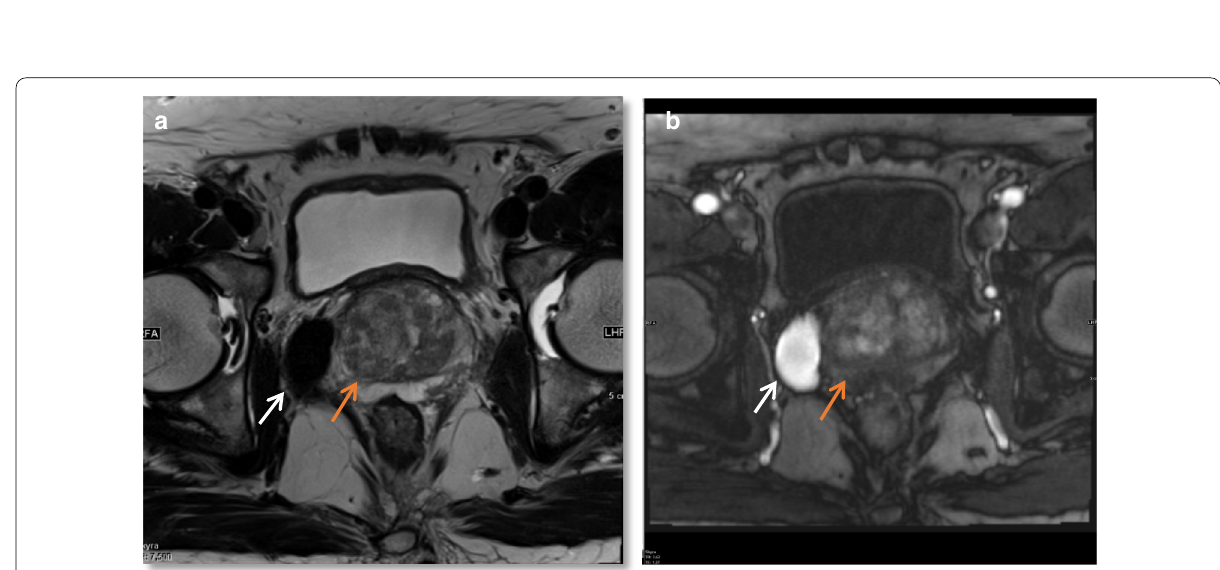
Fig. 25 Periprostatic venous varix a Axial T2W image shows a flow void (white arrow) to the right of the prostate gland (red arrow) and ( b ) dynamic post-contrast axial T1W image shows dynamic enhancement confirming a right-sided periprostatic venous